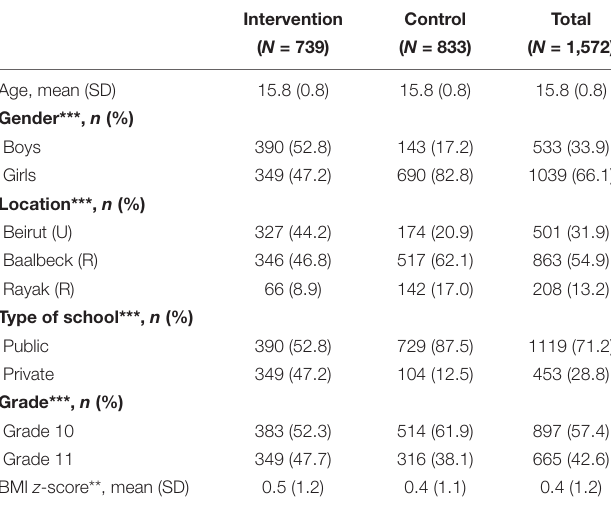
TABLE 1 | Background characteristics of the